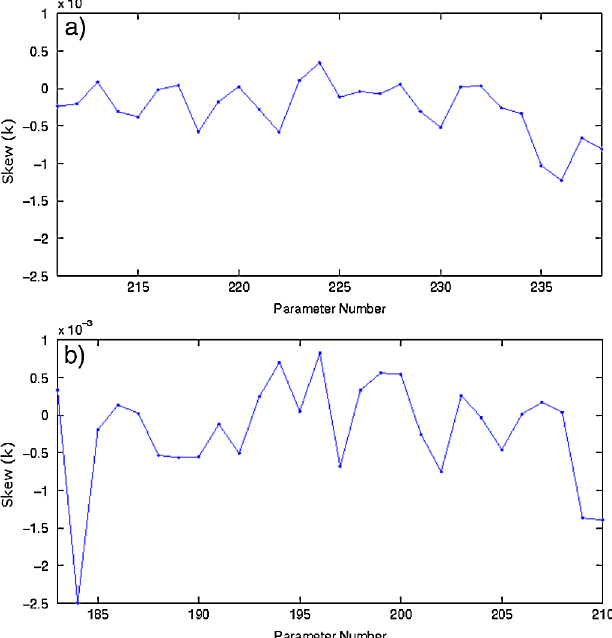
FIG. 4. Examples of LOCO fitted skew quadrupole compo- nents for two of the quadrupole families in the storage ring. Plot (a) shows the focusing quadrupoles in the inner, long girder; plot (b) shows the focusing quadrupoles on the outer, short girders.